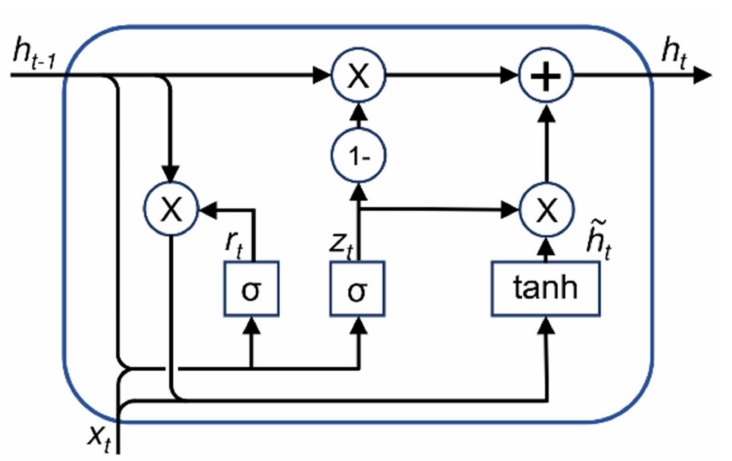
Figure 2. GRU network cell with h t − 1 is the hidden state from the last timestamp, h t is the current hidden state, x t is the current input, r t is the reset gate output, z t is the update gate output, and (cid:101) h t is the candidate hidden